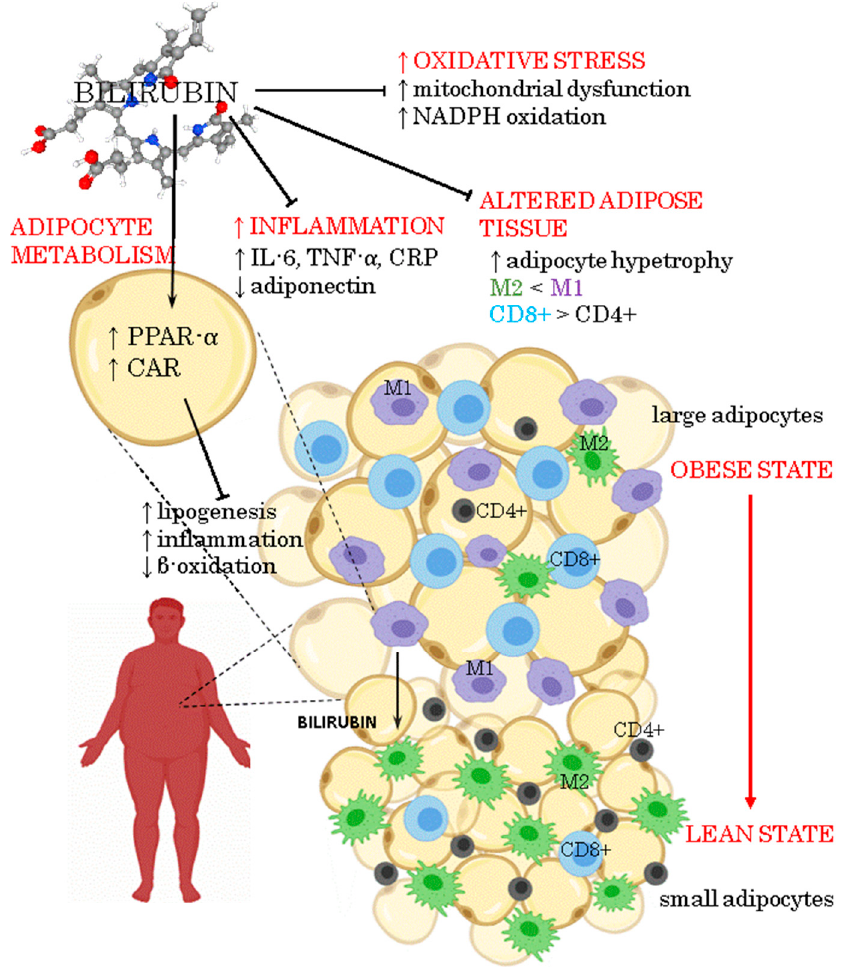
Figure 1. Pleiotropic effects of bilirubin on obesity.